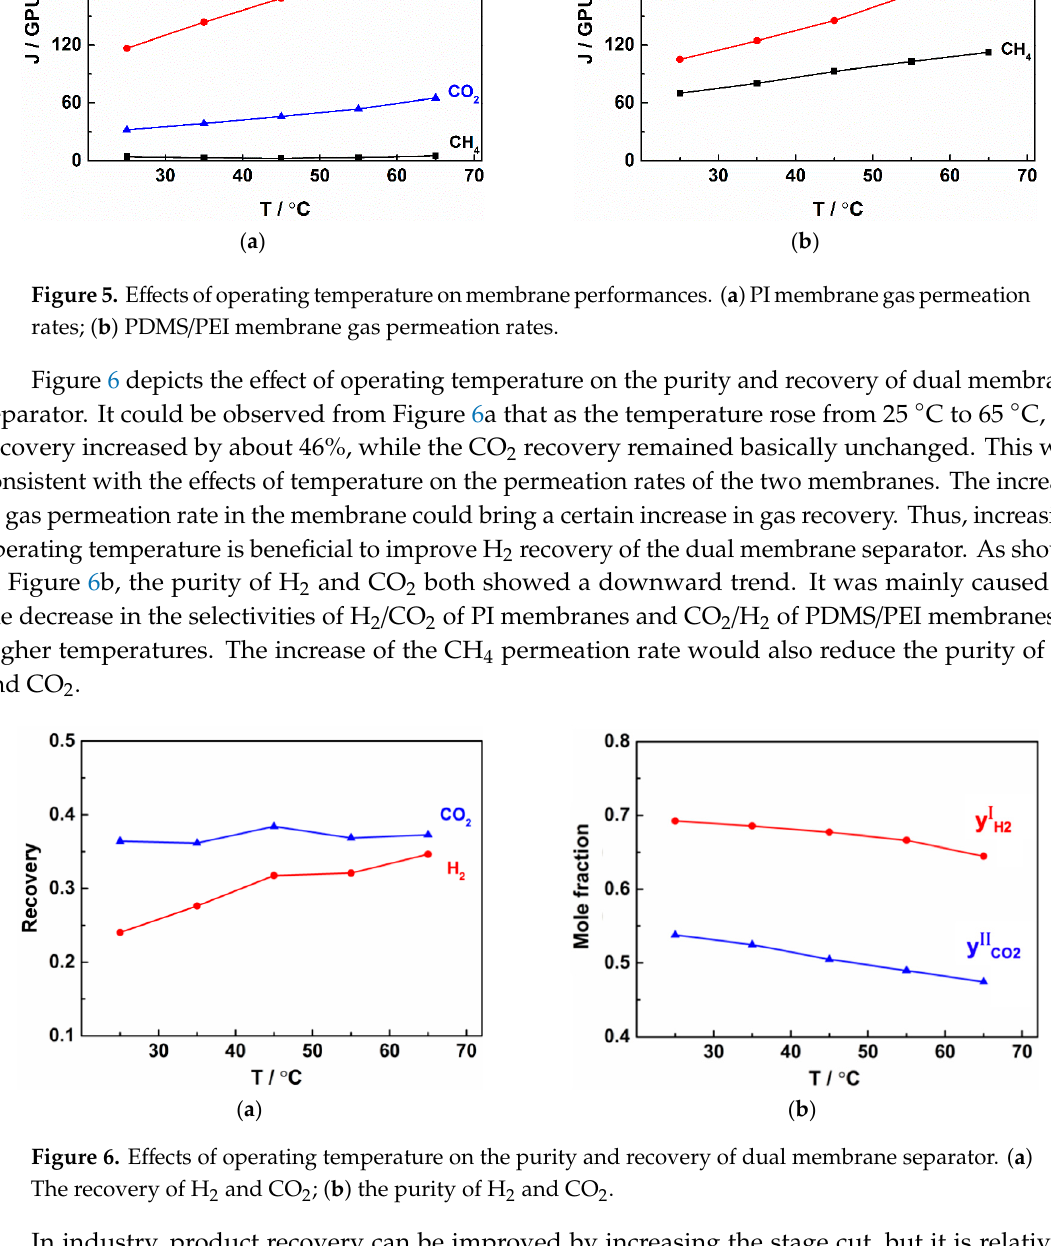
Figure 6. Effects of operating temperature on the purity and recovery of dual membrane separator. ( a ) The recovery of H 2 and CO 2 ; ( b ) the purity of H 2 and CO 2 .